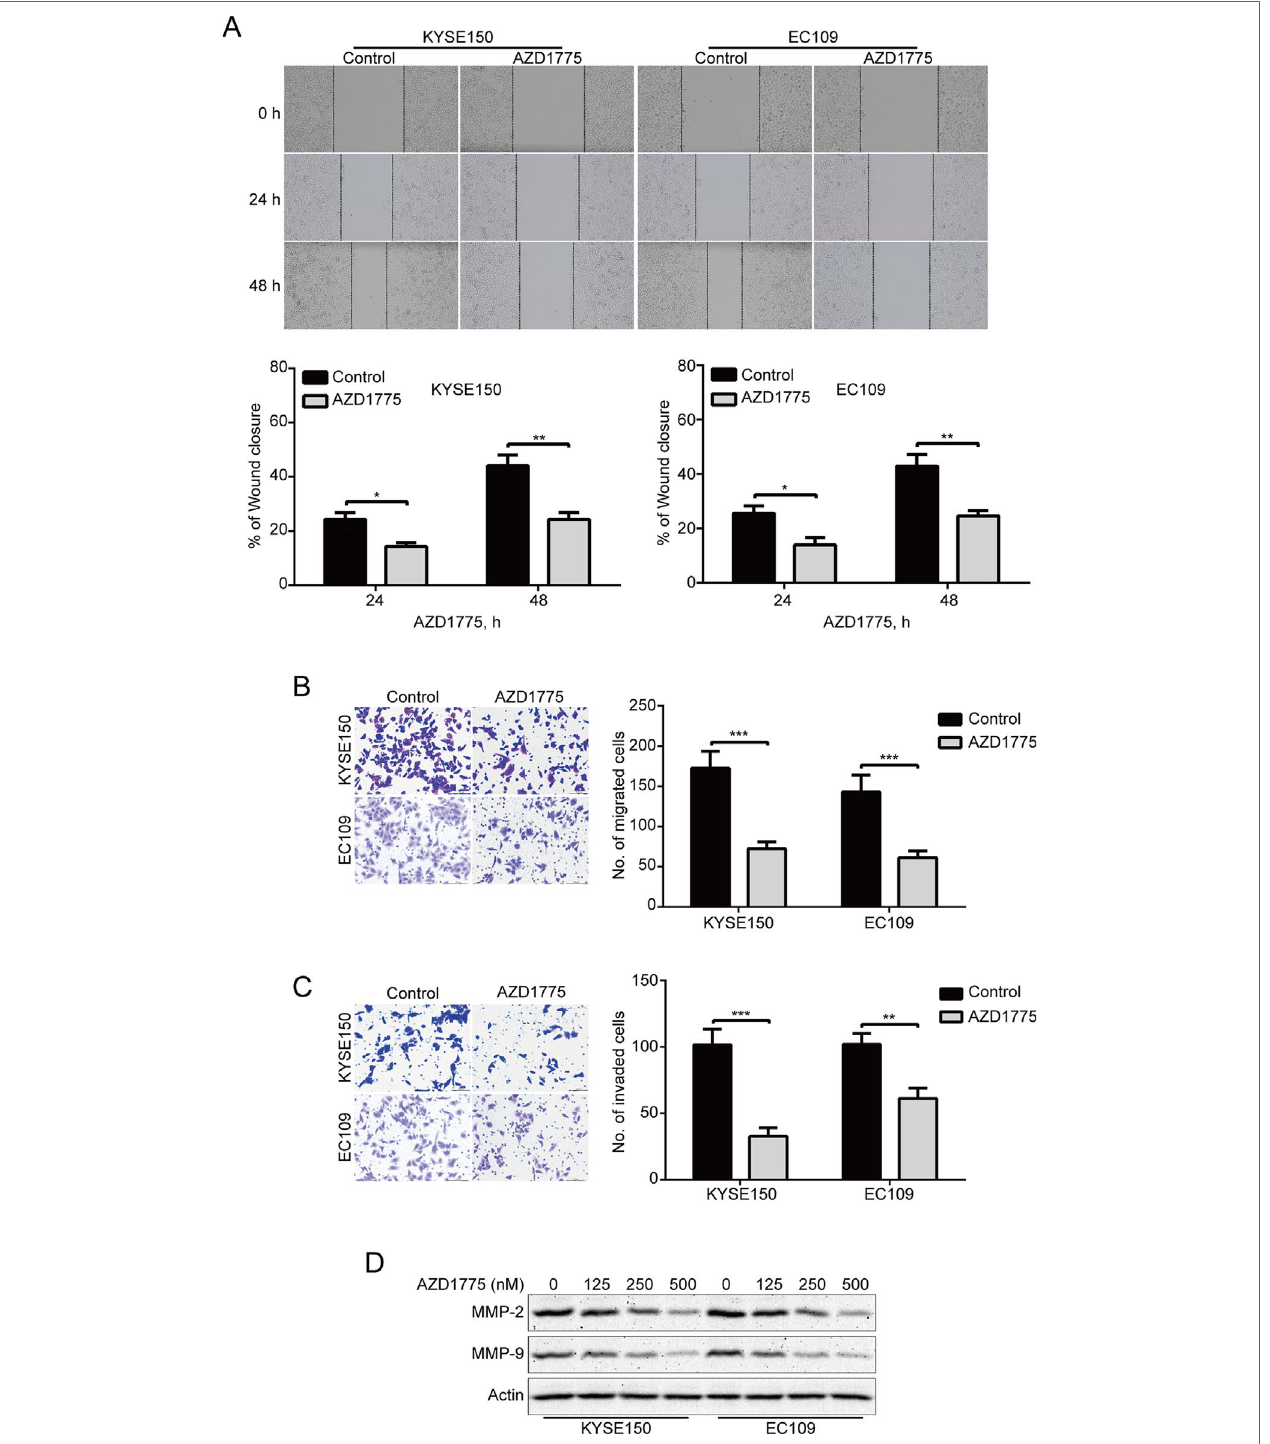
FIGURE 4 | AZD1775 suppresses migration and invasion in ESCC cells. (A) KYSE150 and EC109 cells treated with or without 250 nM AZD1775 for 0, 24, and 48 h after scratching. The average gap width was used to evaluate migration. Bottom: quantitative analysis of the relative breadth of the wound. The wound breadth was normalized to the initial time point (0 h). Columns and error bars represent mean ± SD ( n = 6 per group). (B, C) KYSE150 and EC109 cells were treated with 250 nM AZD1775 for 48 h and then subjected to transwell migration (B) and invasion (C) assay. Left: representative images; right: quantitative analysis from five random fields. Scale bar: 100 μm. Mean; error bar, SD. (D) Western blotting analysis of whole-cell lysates of KYSE150 and EC109 cells that were treated with different concentrations of AZD1775 for 48 h. * P < 0.05, ** P < 0.01, *** P < 0.001, by Student’s t